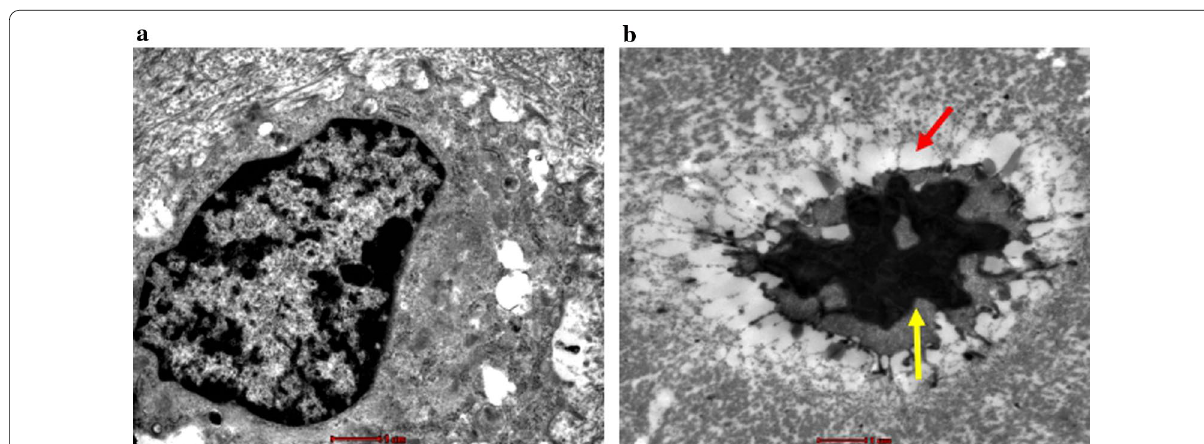
Fig. 5 Morphological changes of apoptotic cells was detected via TEM ( 9900). Control group (images a ): osteocyte was round or oval, large in × size and rich in organelle, the chromatin was clear and uniform, and the nuclear membrane was intact. Model group showed typical apoptotic morphological features: the bone cell volume became smaller, the nucleus was pyknotic, the shape was irregular, the cell edge vacuolation, the nuclear chromatin was concentrated and marginalized (the red arrow), and the intracellular electron density was deepened, the heterochromatin was rich in the nucleus and distributed in large pieces (the black arrow). (images b ). Scale bar 2 =